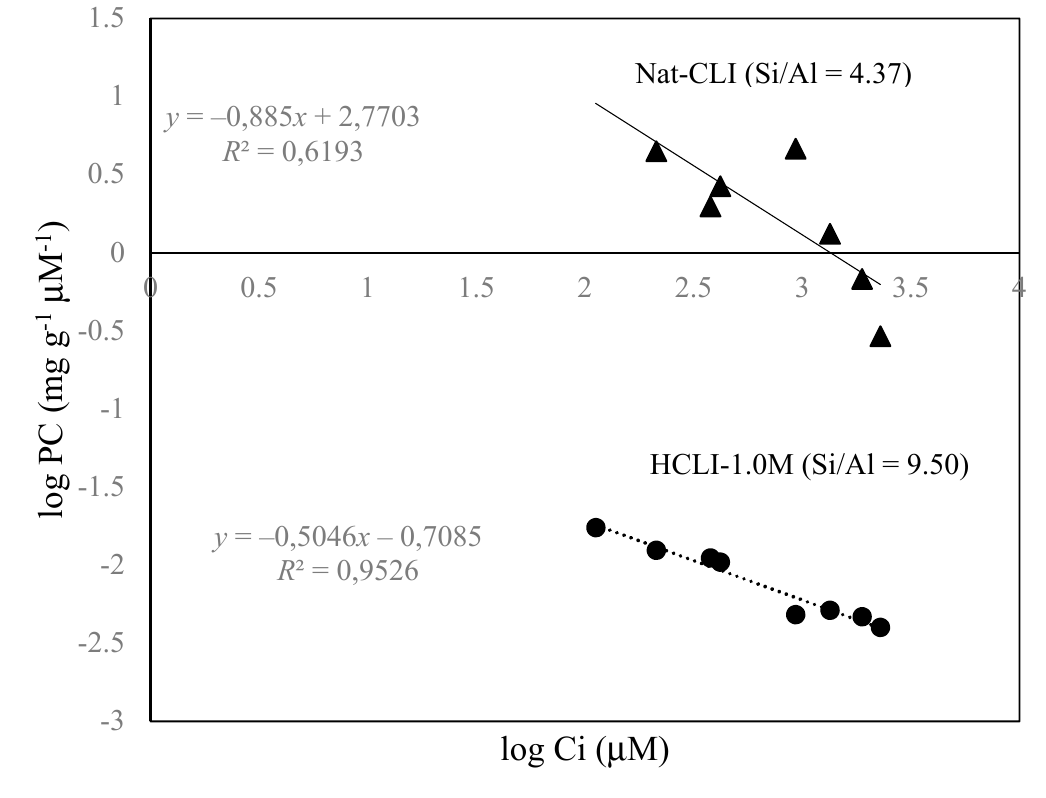
Figure 8. Comparison between the log PC for Nat-CLI and HCLI-1.0M as a function of log Ci of Pb(II) in solution.